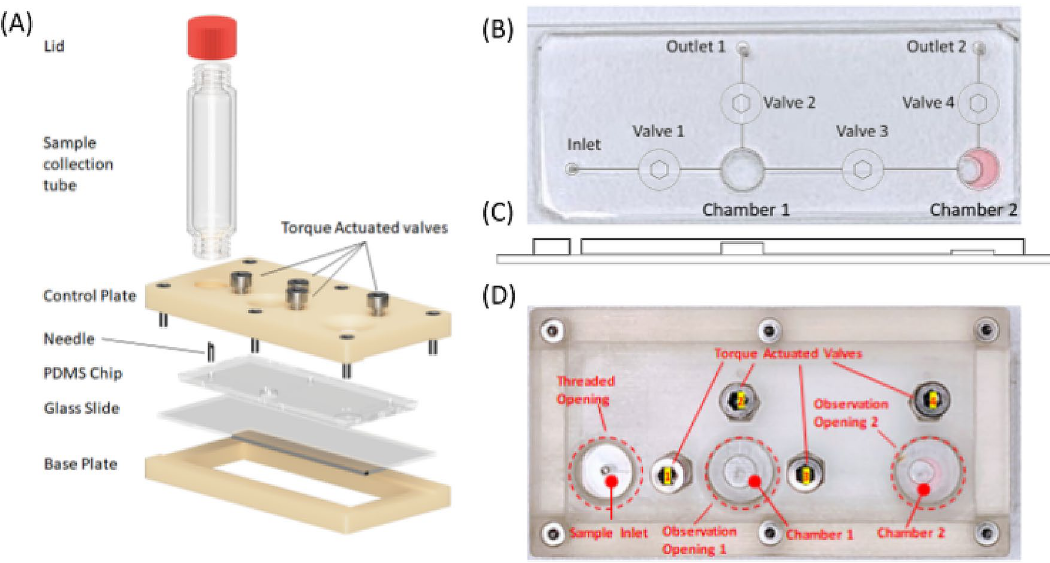
Figure 4. Disposable cartridge design. ( A ) Exploded view of the cartridge-sample collection tube assembly. ( B ) Microfluidic schematic overlapped with a photograph of the microfluidic chip, associated with ( C ) a sectioned view of the chip. ( D ) Top view of the assembled main